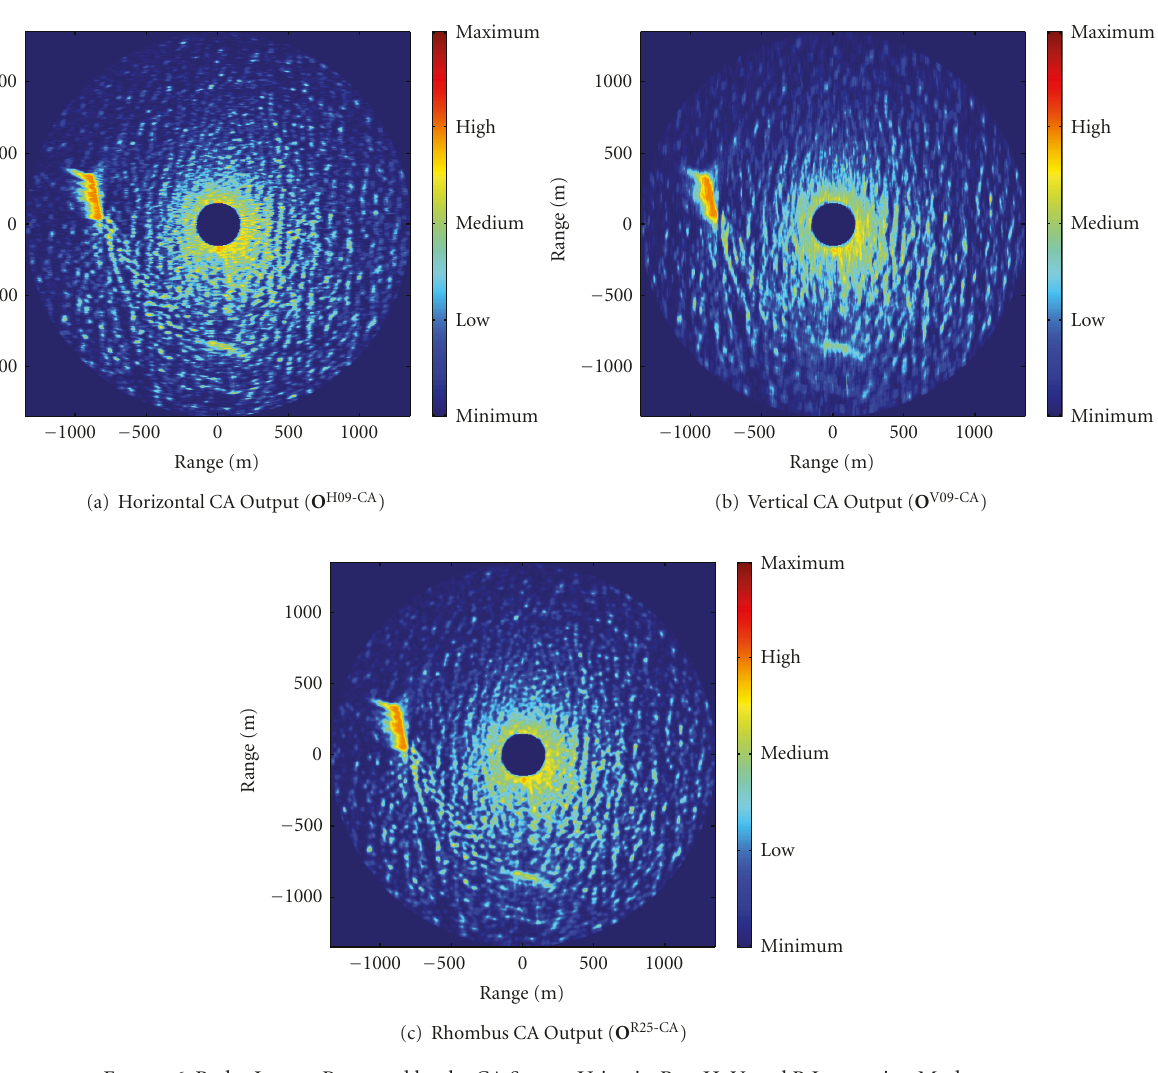
Figure 6: Radar Images Processed by the CA System Using its Best H, V, and R Integration